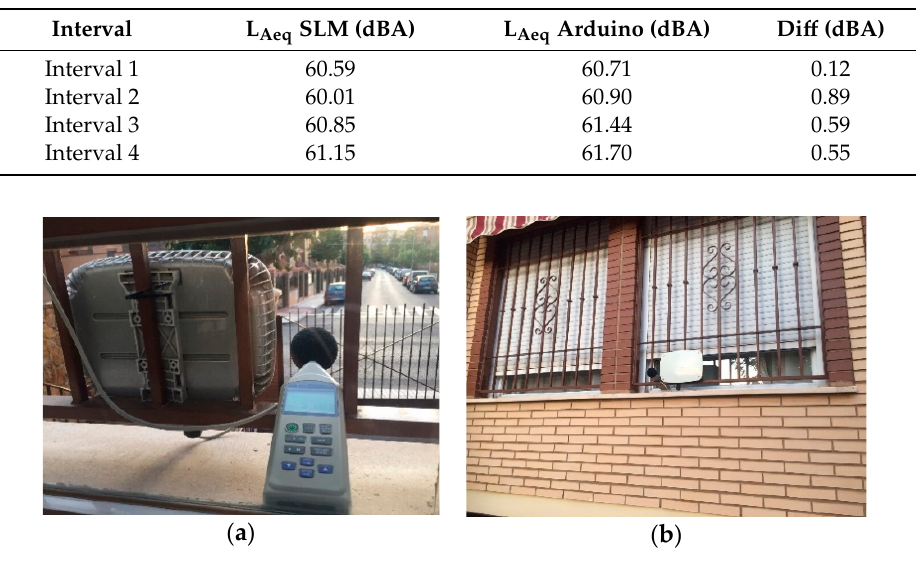
Figure 7. The SLM and Arduino Due deployed in a street for the tests: ( a ) back view; ( b ) front view.